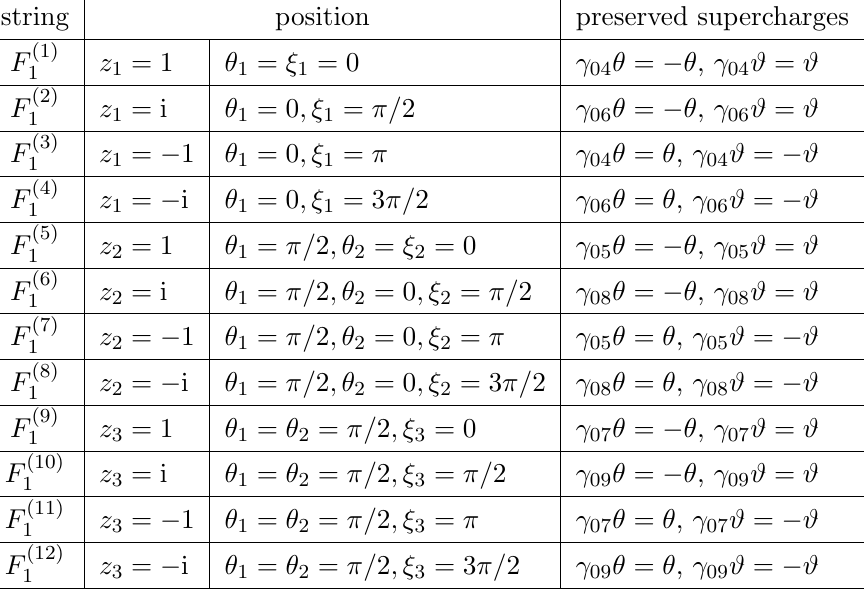
solutions. The 1